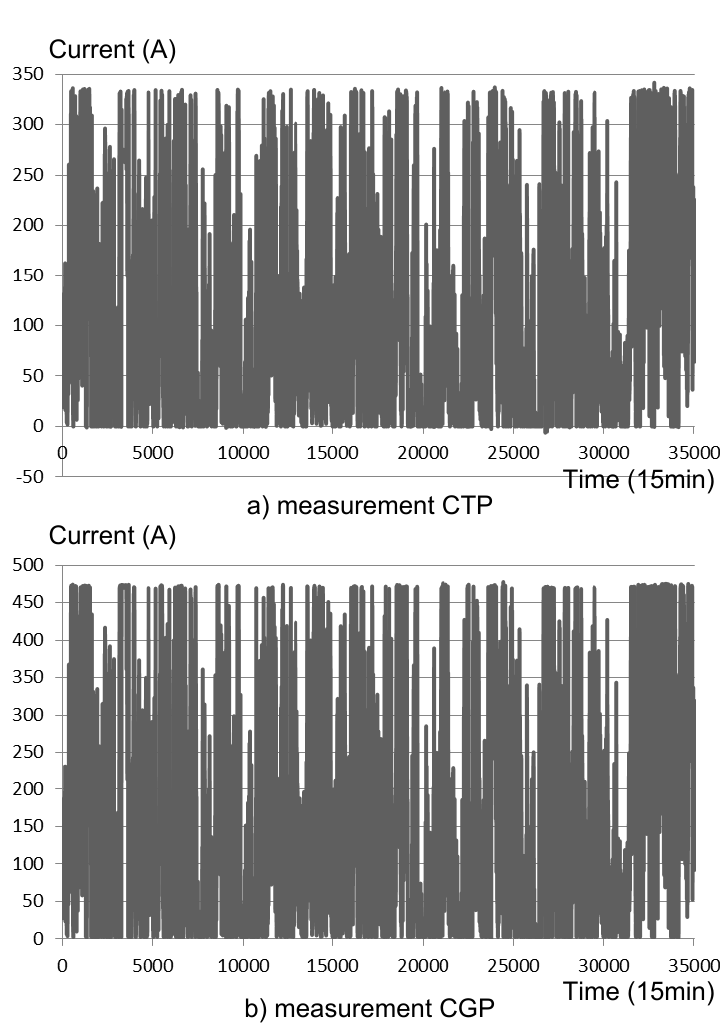
Figure 5. Measurements test